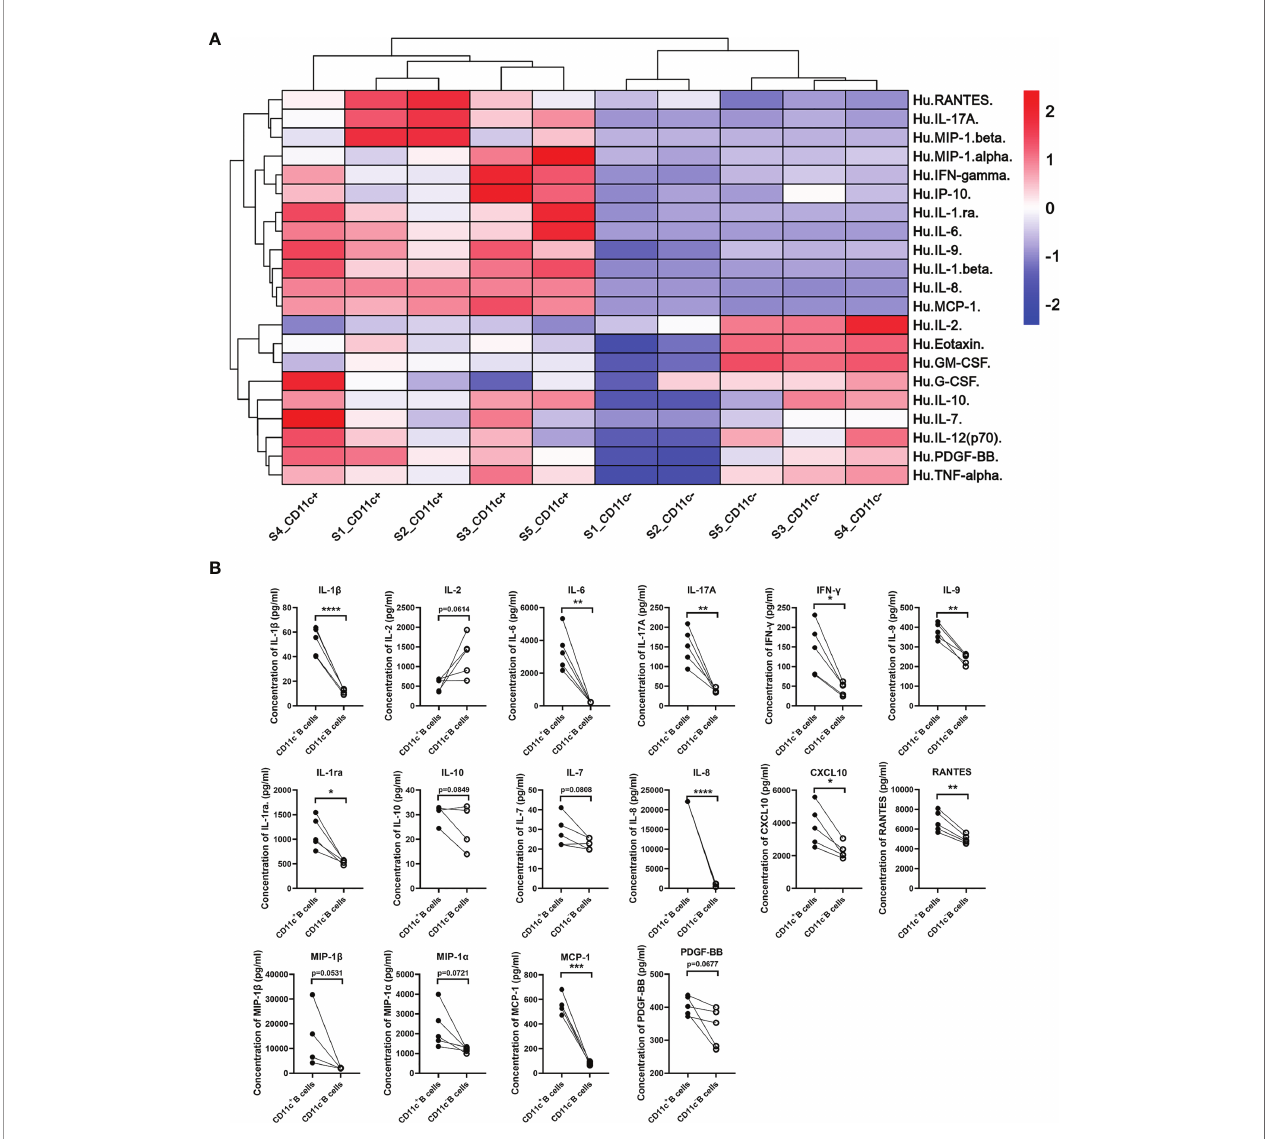
FIGURE 8 | Cytokine secretion pro fi le of paired CD11c + B cells and CD11c - B cells from GD patients. (A) Cytokine secretion pattern heatmap of paired CD11c + B cells and CD11c - B cells from 5 batches of GD patients evaluated with a Luminex liquid suspension chip. (B) Cytokines with a signi fi cant change or notable trend between paired CD11c + B cells and CD11c - B cells are displayed. Paired Student ’ s t test. P < 0.1 was considered indicative of a trend; P < 0.05 was considered statistically signi fi cant. ns, not signi fi cant; * P < 0.05; ** P < 0.01; *** P < 0.001; **** P <